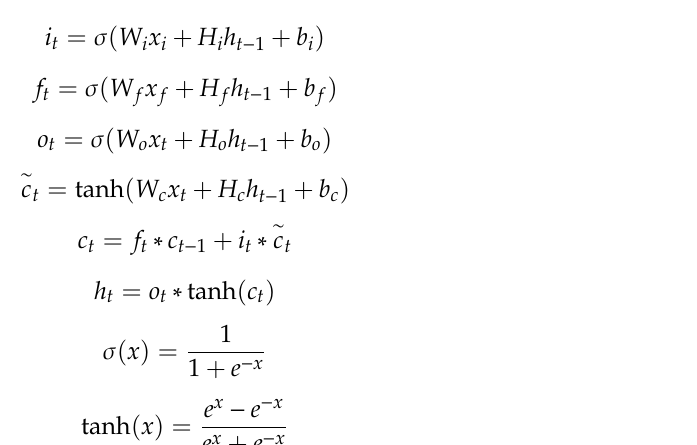
Figure 3. The hidden layer of long short-term-memory (LSTM) cell structure.